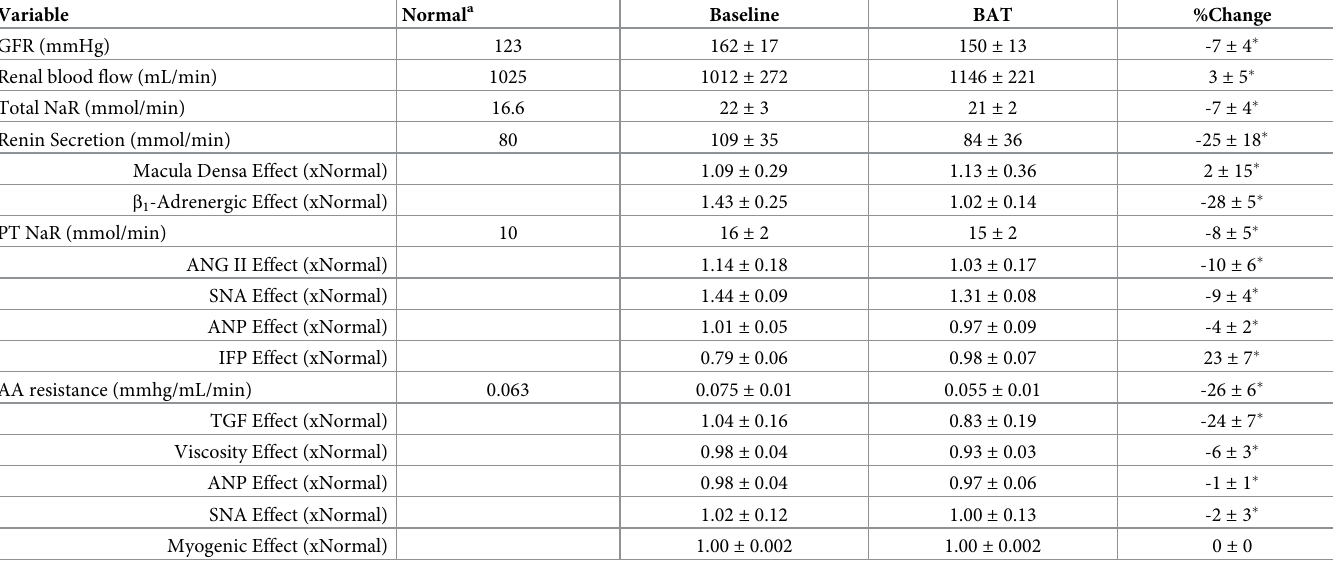
Table 2. Renal responses at normal model conditions and in the calibrated hypertensive virtual population before and after 1 month of baroreflex activation therapy. Variable